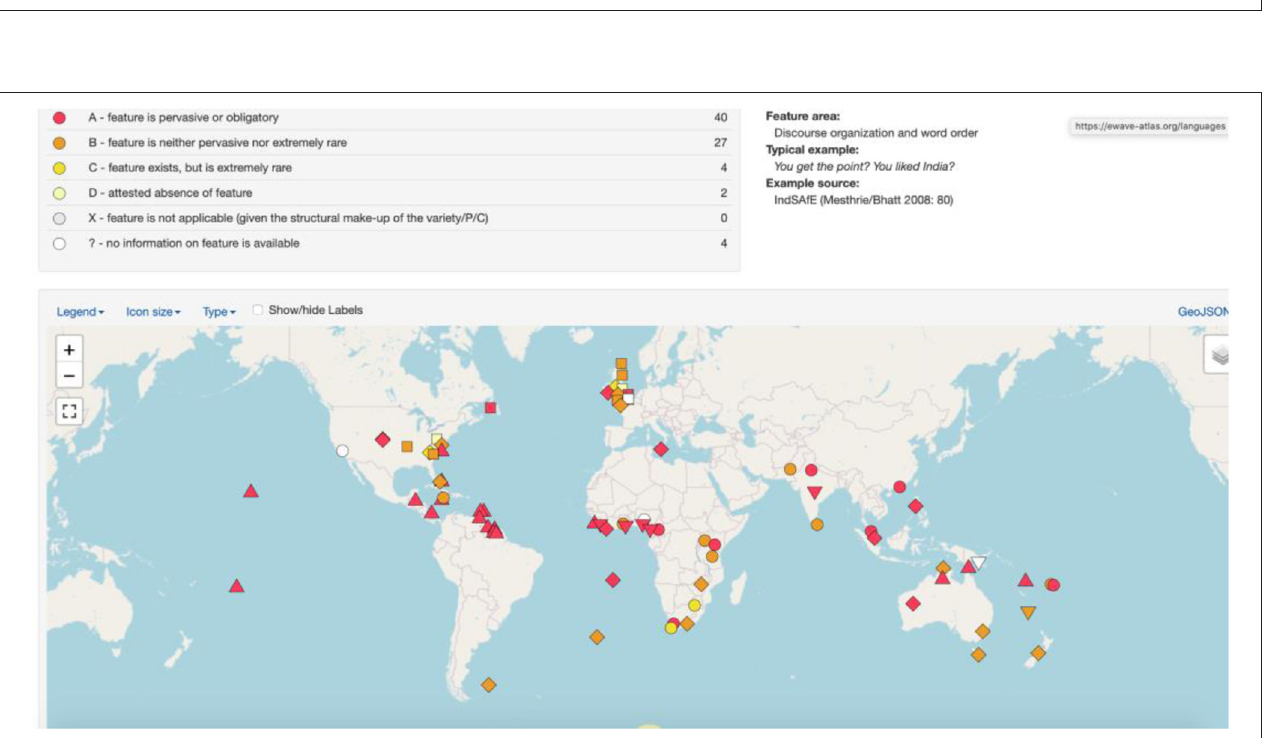
FIGURE 10 | Screenshot of eWAVE Feature 229 “No inversion/no auxiliaries in main clause yes/no questions” (from https://ewave-atlas.org/parameters/229#2/7.0/7. 7).